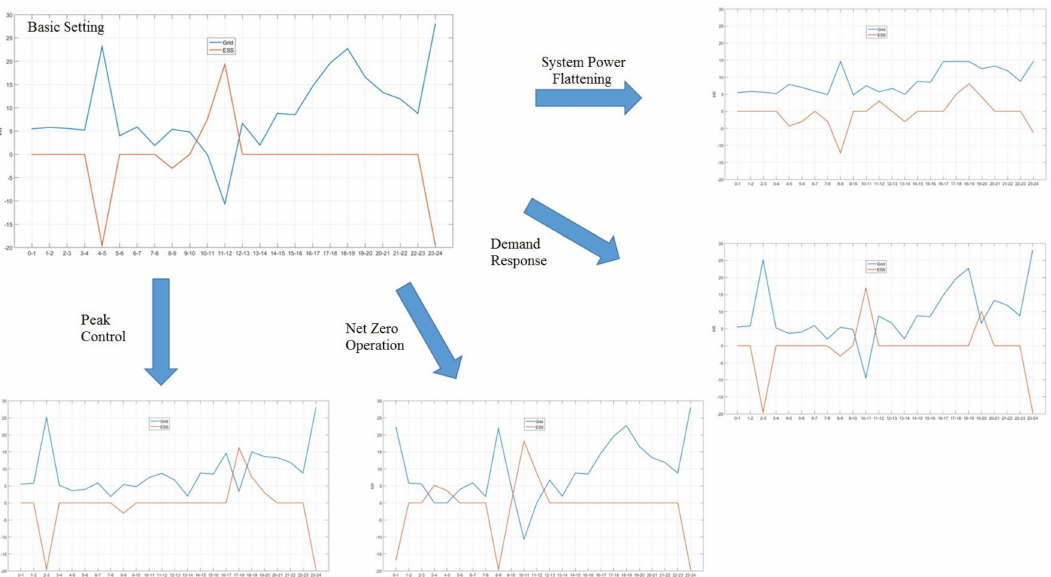
Figure 2. Diagram showing the changes in system power usages, ESS charging / discharging according to the external operating conditions.